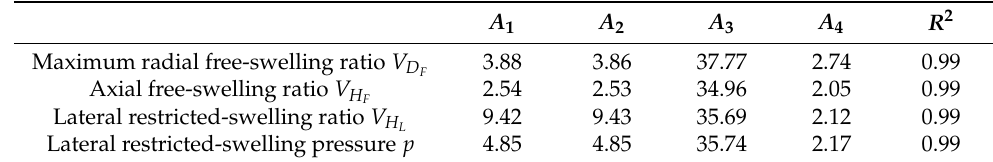
Figure 12. Swelling ‐ time model. ( a ) Maximum radial free ‐ swelling ratio; ( b ) axial free ‐ swelling ratio; Figure 12. Swelling-time model. ( a ) Maximum radial free-swelling ratio; ( b ) axial free-swelling ratio; ( c ) lateral restricted ‐ swelling ratio; ( d ) lateral restricted ‐ swelling pressure. ( c ) lateral restricted-swelling ratio; ( d ) lateral restricted-swelling pressure. Table 6. Parameters of S ‐ model. Table 6. Parameters of